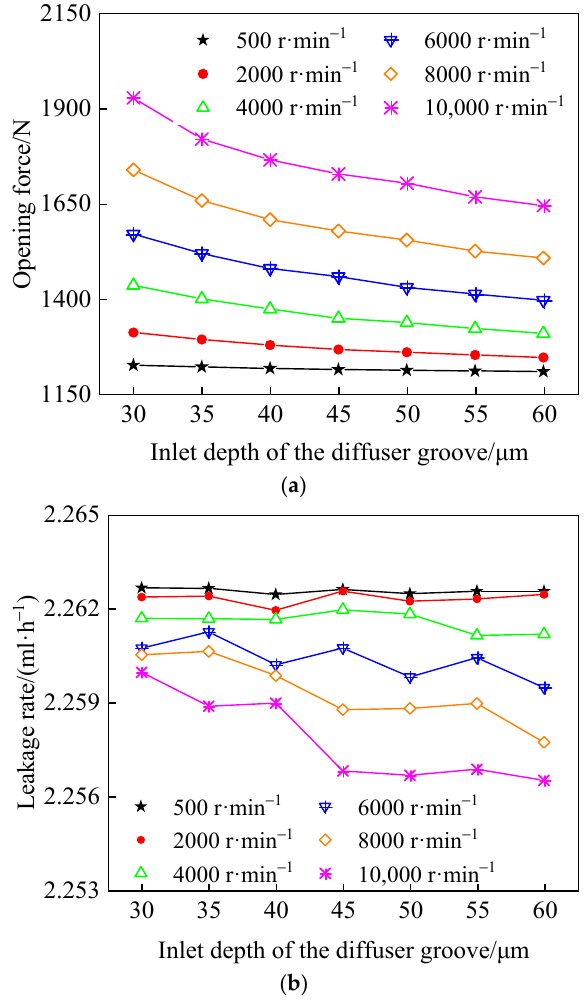
Figure 10. Influence of the diffuser groove inlet depth on its sealing performance: ( a ) Influence on the opening force; ( b ) Influence on the leakage rate. ( r k = 34 mm, r o = 30.6 mm, N g = 32, γ = 0.5, λ = 0.9, α = 30°, Δ p = 0.5 MPa).